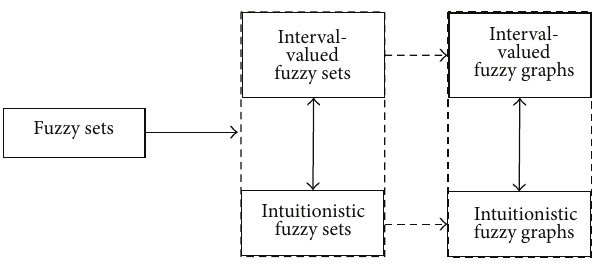
Figure 10: Links between models.